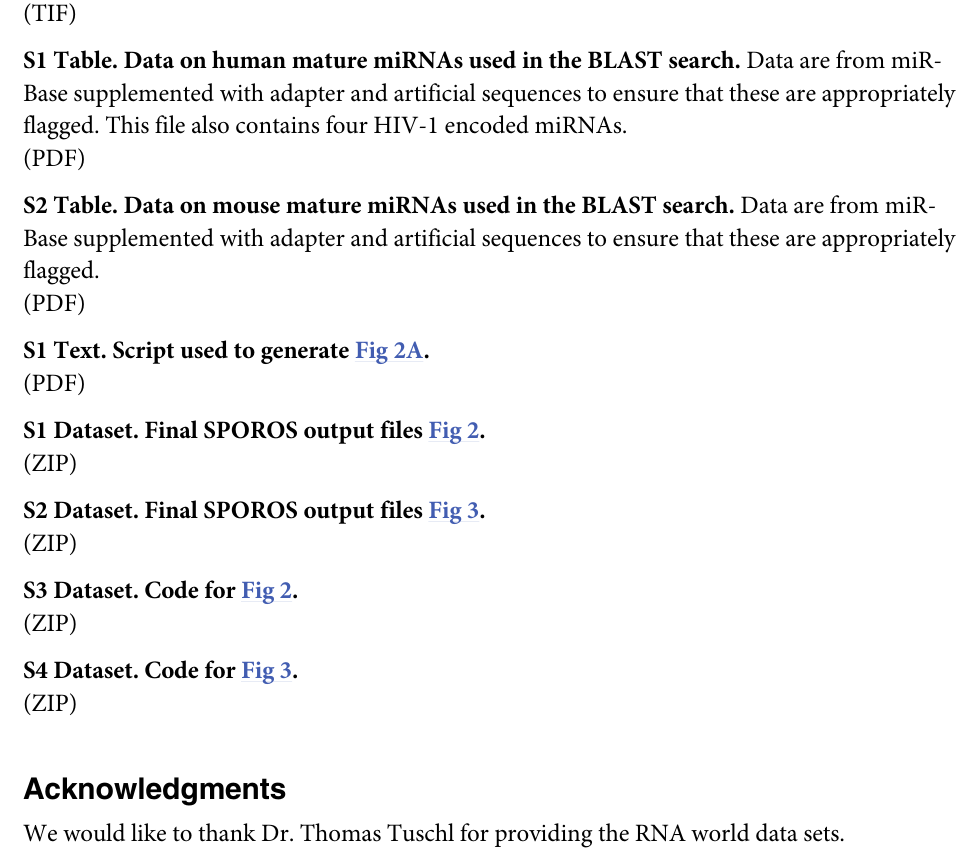
S4 Dataset. Code for Fig